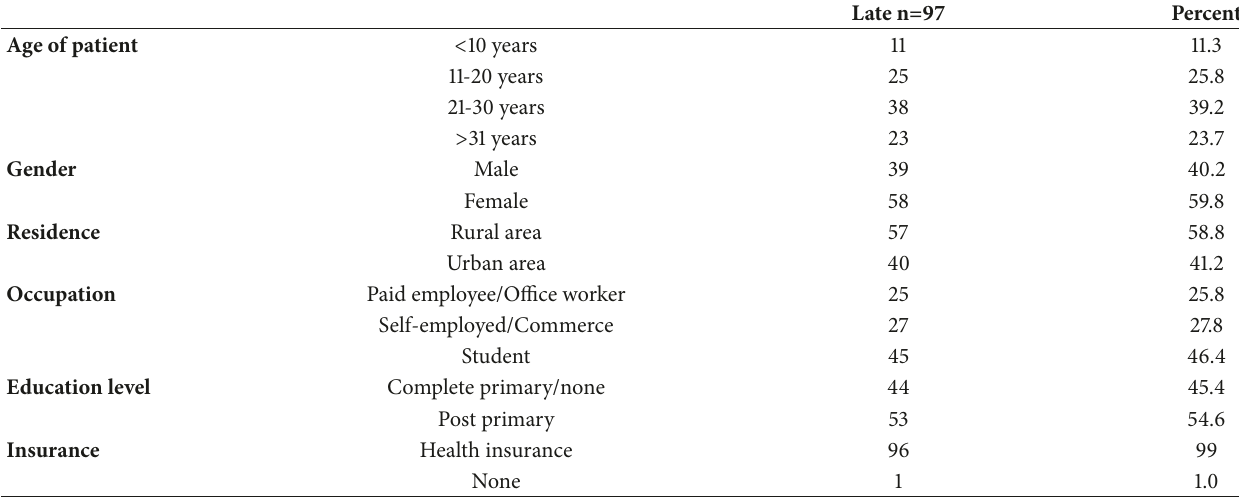
Table 1: Characteristic of patients with delayed care seeking for treatment of CSOM.